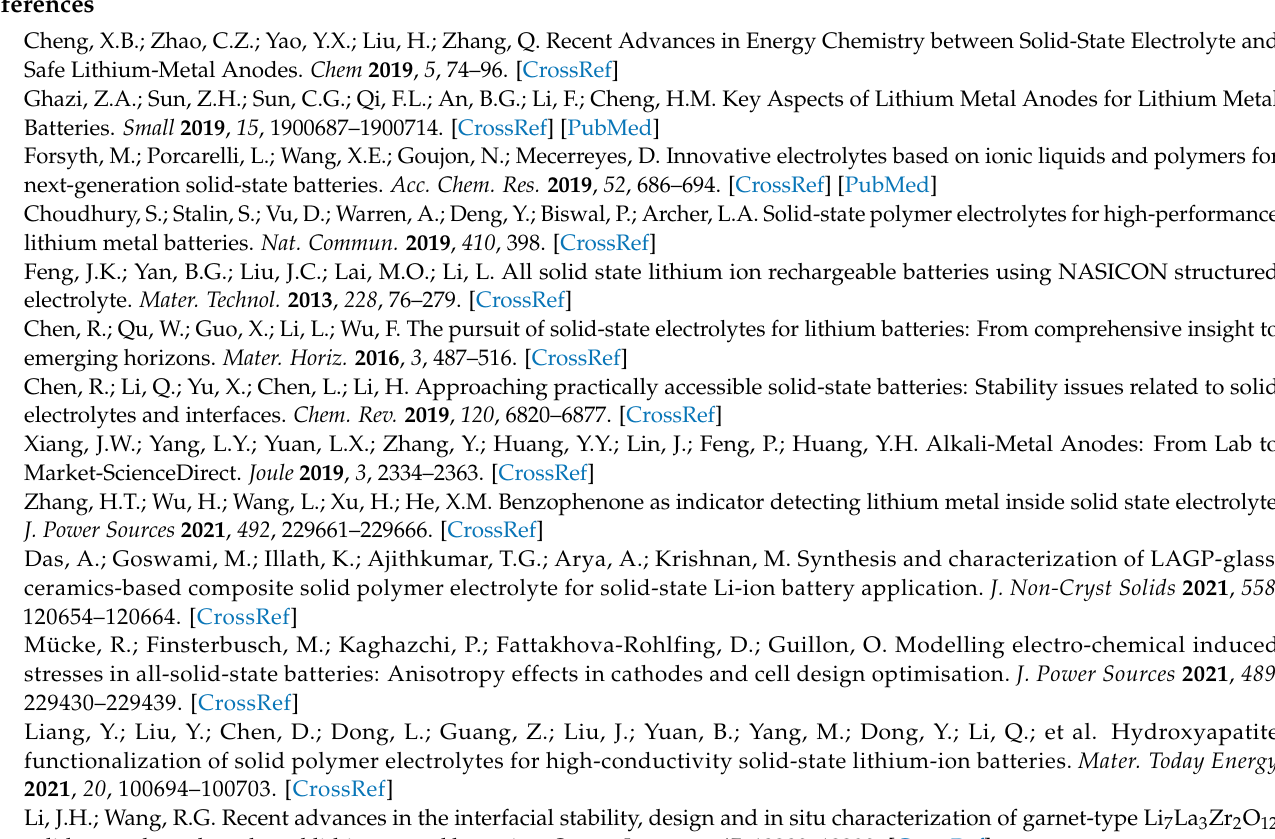
Figure S6: Physical image of the surface before and after the SPLL cycle; Figure S7: XRD before and after SPLL cycle; Figure S8: Physical image of the surface before and after the SPLL cycle. SP is an electrolyte membrane formed by stirring and drying three polymers in DMF (among them, DMF 30 mL, PVA 1 g, PES 2 g, PVDF 5% copolymerized base); SPL is added on the basis of SP LiBF4